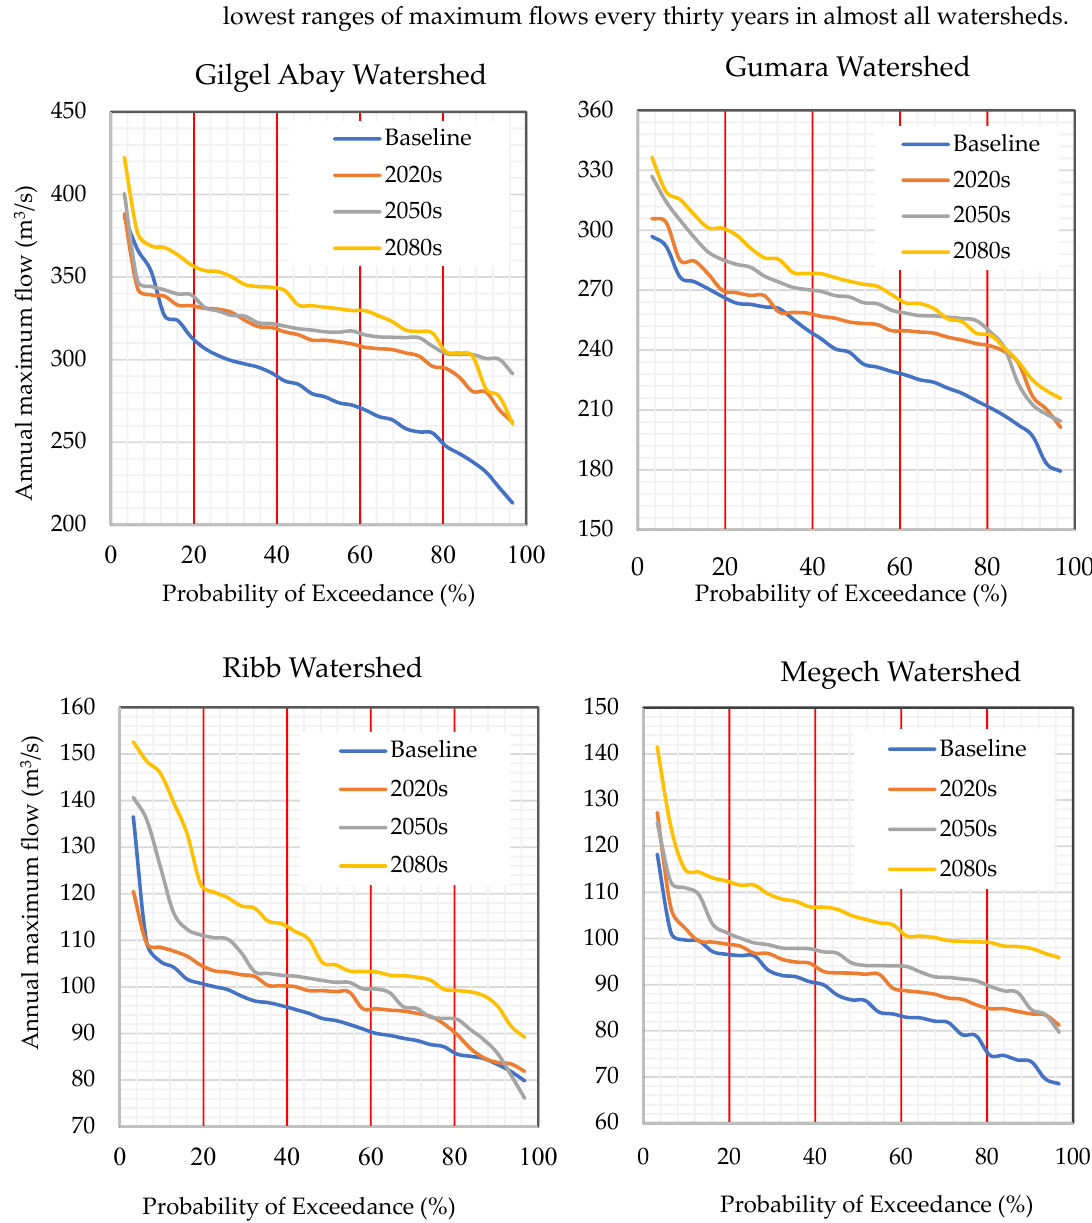
Figure 6. Flow Duration Curve of High flows of watersheds.